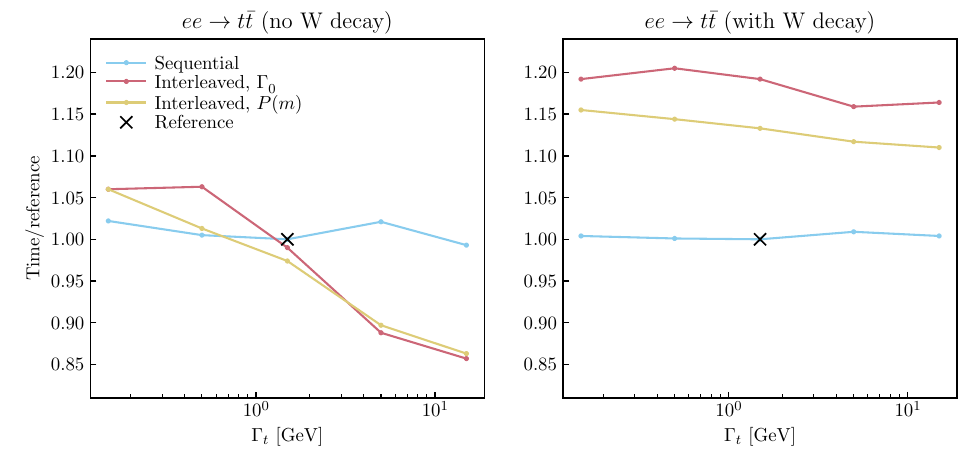
(cid:112) s = 500GeV, Figure 3: Relative time consumption to generate e + e − → t ¯ t events at as functions of the top quark width, for sequential (blue) and interleaved resonance decays with fixed (red) and the default dynamical (yellow) scale choices. Left: with stable W bosons. Right: with inclusively decaying W bosons. In both cases, sequen- = 1.5GeV was used as the reference case. The run-time for the tial decays with Γ t reference sample without W decays was 1.7 ms / event, increasing to 3.5 ms / event with W decays included. Tests performed on a single 2.7 GHz Intel Core i7 CPU, with clang version 13.0.0 with -O2